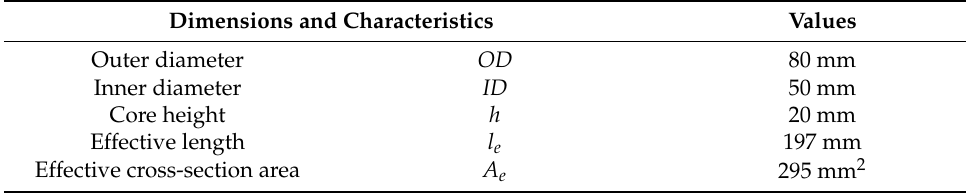
Table 1. Toroidal Core Dimensions and Properties.